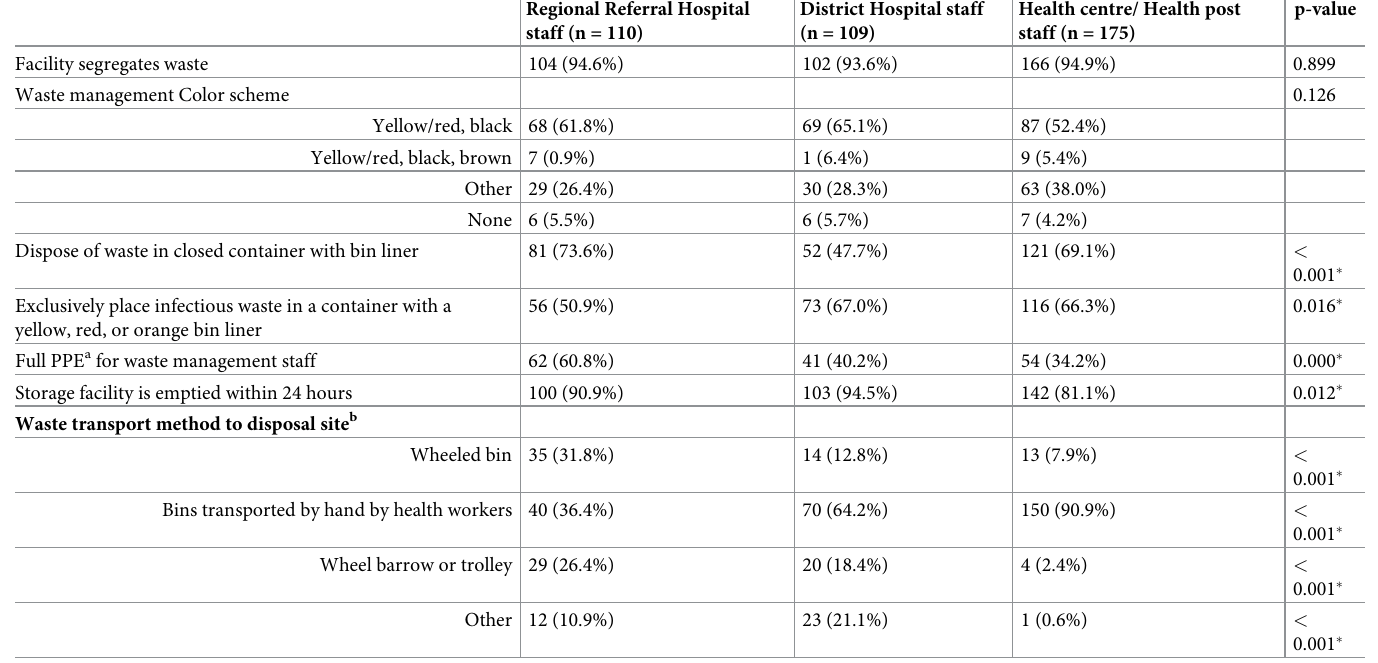
Table 6. Waste management practices reported from staff